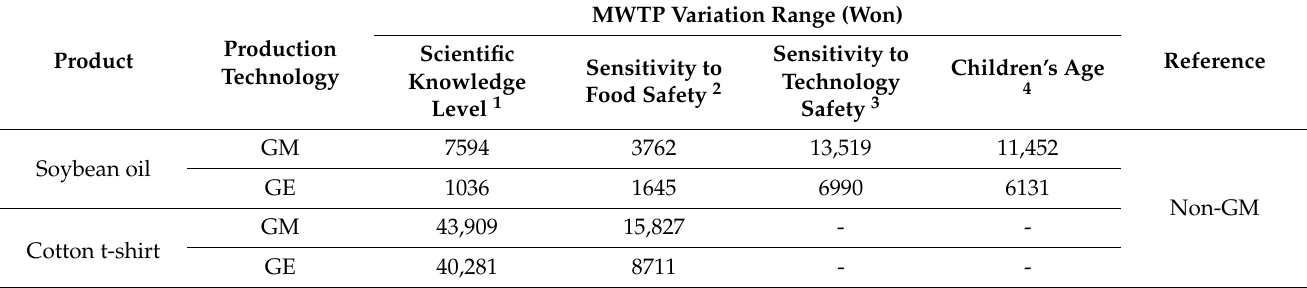
Table 10. MWTP variation range for the production technology according to respondents’